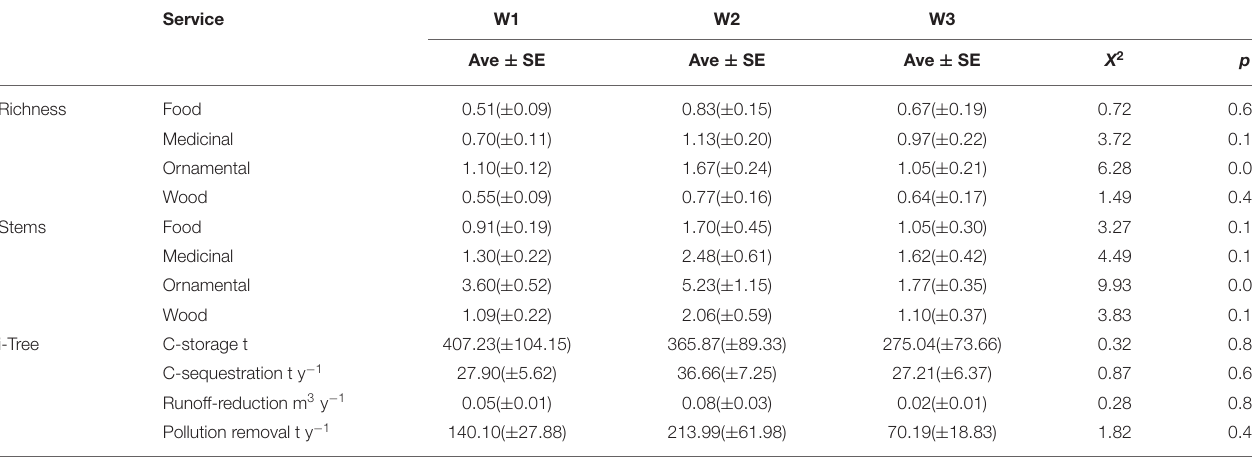
TABLE 3 | Differences among wards in the average number of species and stems per plot for each of four ecosystem service categories (food, medicinal, ornamental, wood) and average values of services calculated by i-Tree.